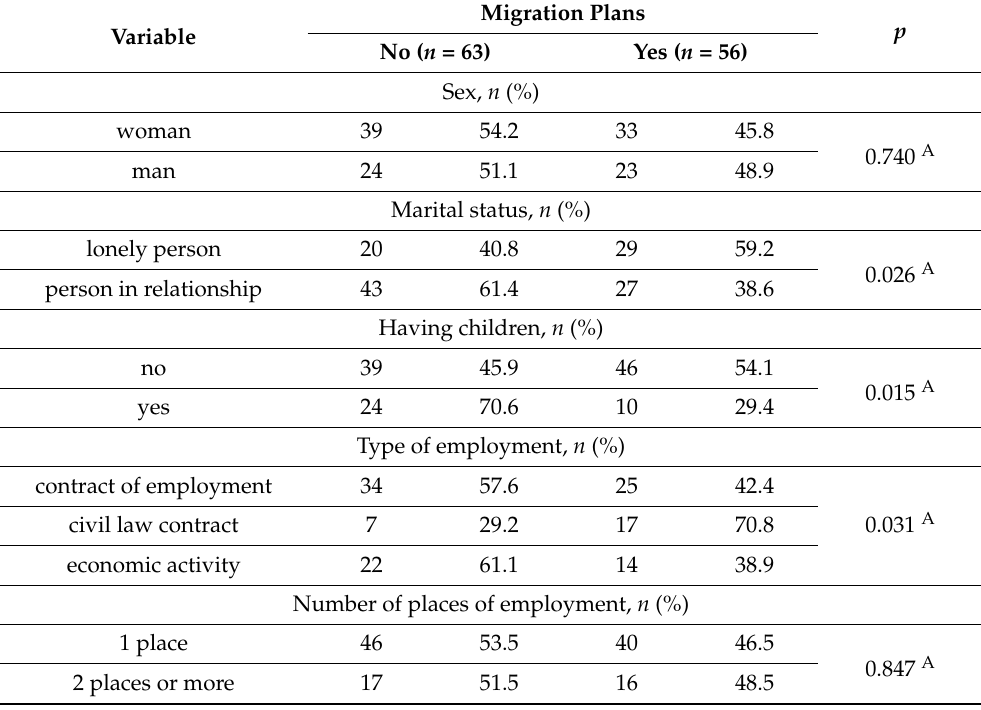
Table 2. Characteristics of practicing physiotherapists according to migration